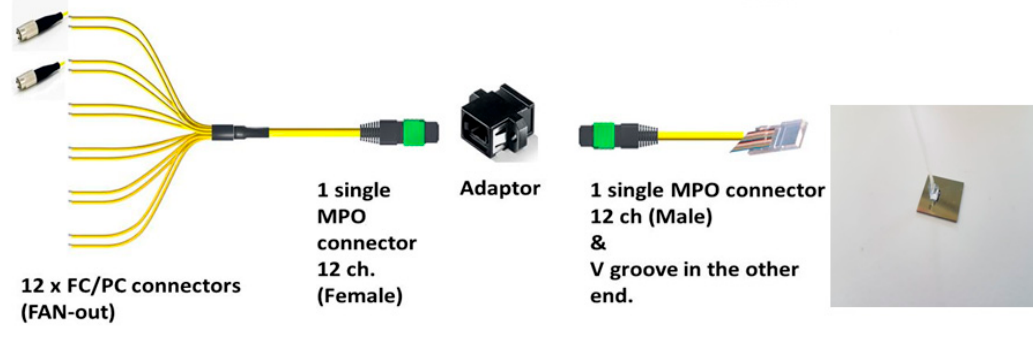
Figure 3. Fiber array attachment and optical connectors.